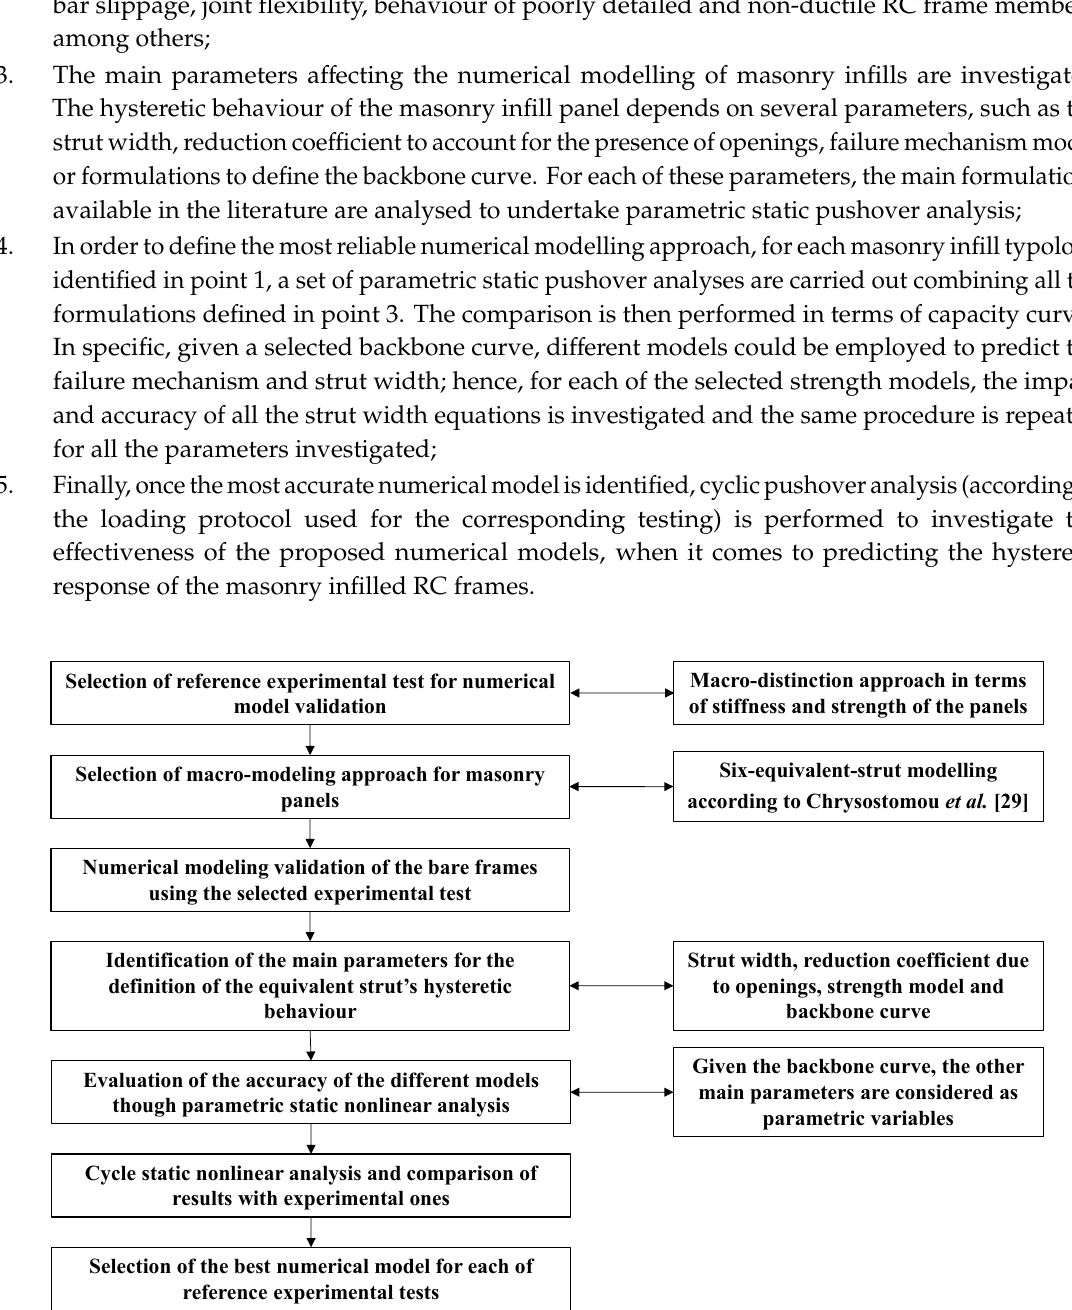
Figure 1. Research methodology framework.